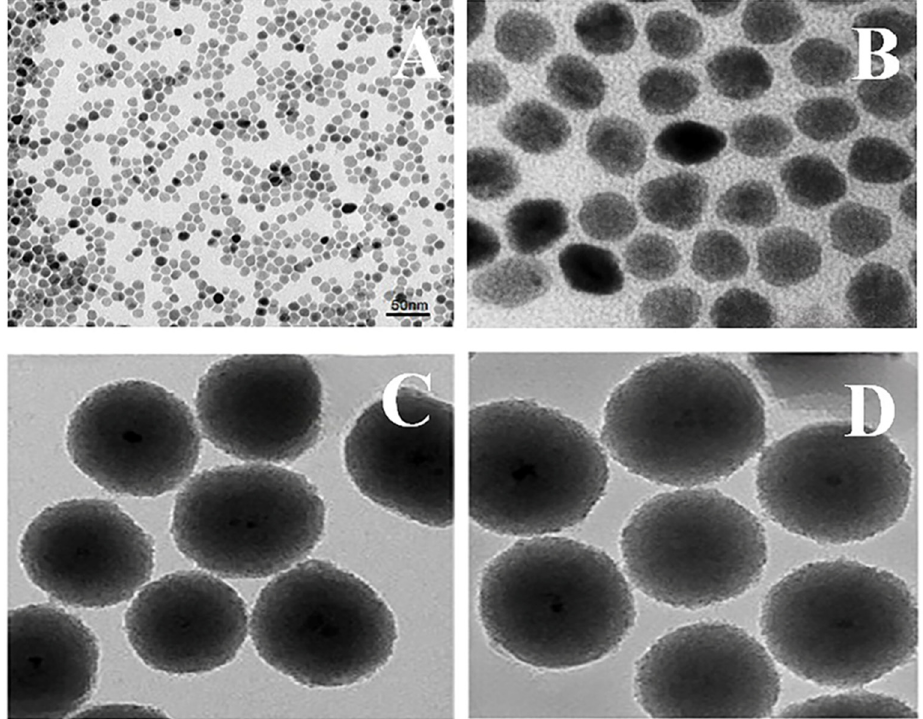
Figure 6. TEM morphological images for cytarabine-loaded TINPs (CY-TINPs) ( A ) after 3-month stability studies and ( B – D ) are ultra-magnified TEM morphological image.